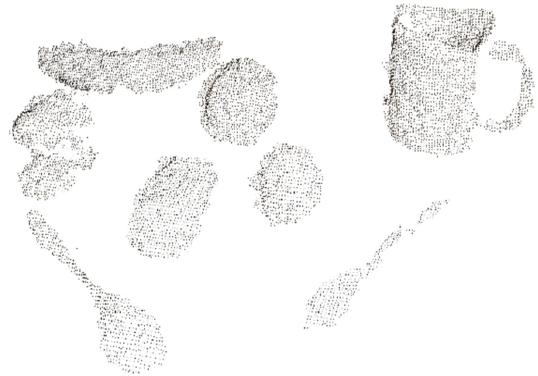
Figure 7. Object image after Euclidean cluster extraction has been applied.